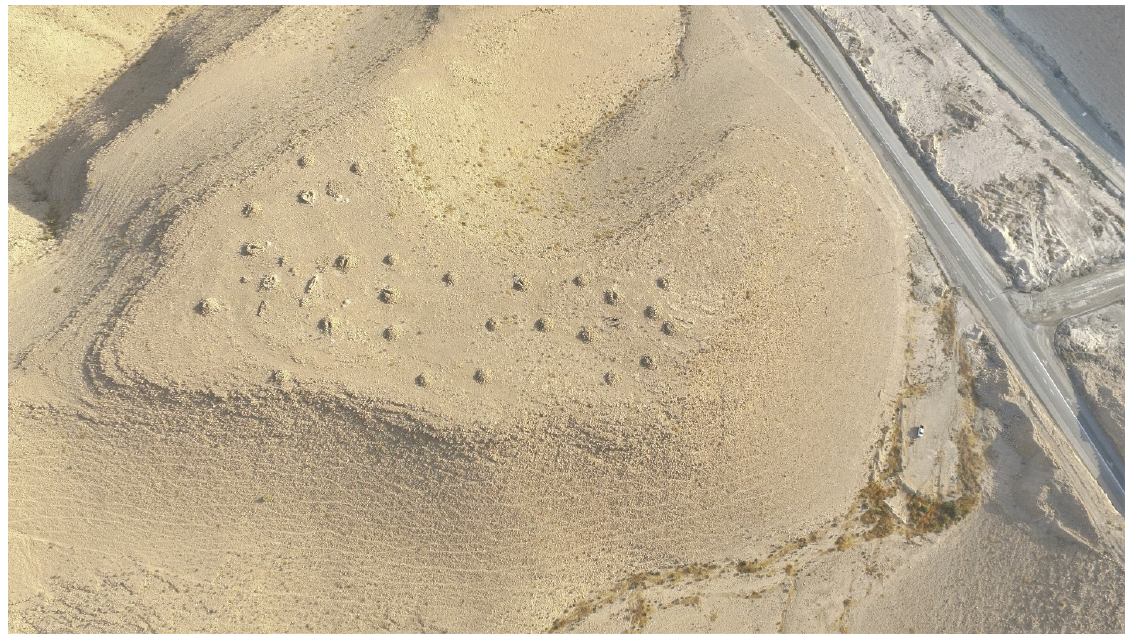
Figure 8 Tamar I cairn field (Drone photo by R.